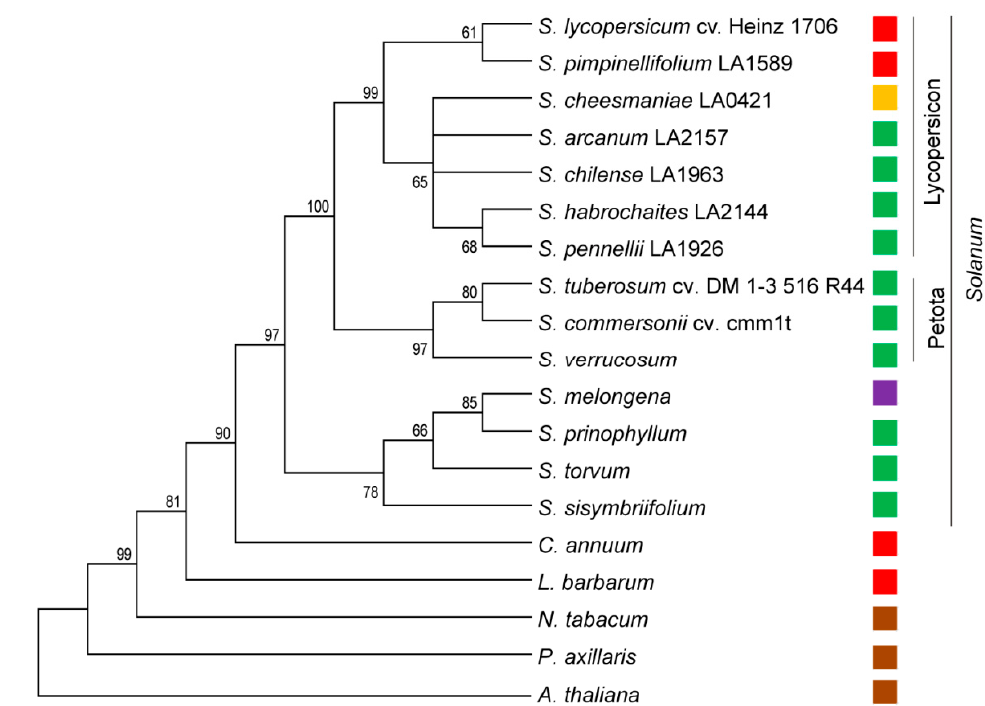
Figure 5. Evolutionary relationship among Solanaceae species (Solanum lycopersicum, Solanum pimpinellifolium, Solanum cheesmaniae, Solanum arcanum, Solanum chilense, Solanum habrochaites, Solanum pennellii, Solanum tuberosum, Solanum commersonii, Solanum verrucosum, Solanum melongena, Solanum prinophyllum, Solanum torvum, Solanum sisymbriifolium, Capsicum annuum, Lycium barbarum, Nicotiana tabacum, and Petunia axillaris) based on the PSY1 coding sequences. Arabidopsis thaliana (Brassicaceae) PSY was used as an outgroup. Analysis was performed using the neighbor-joining method. The optimal tree with the sum of branch length = 2.35980228 is shown. Percentages of replicate trees in which the associated taxa clustered together in the bootstrap test (1000 replicates) are shown next to the branches. The tree is drawn to scale, with branch lengths in the same units as those of the evolutionary distances used to infer the phylogenetic tree. The evolutionary distances were computed using the Jukes–Cantor method and are in the units of the number of base substitutions per site. For each species, the color of the ripe fruit is indicated to the right of the name.